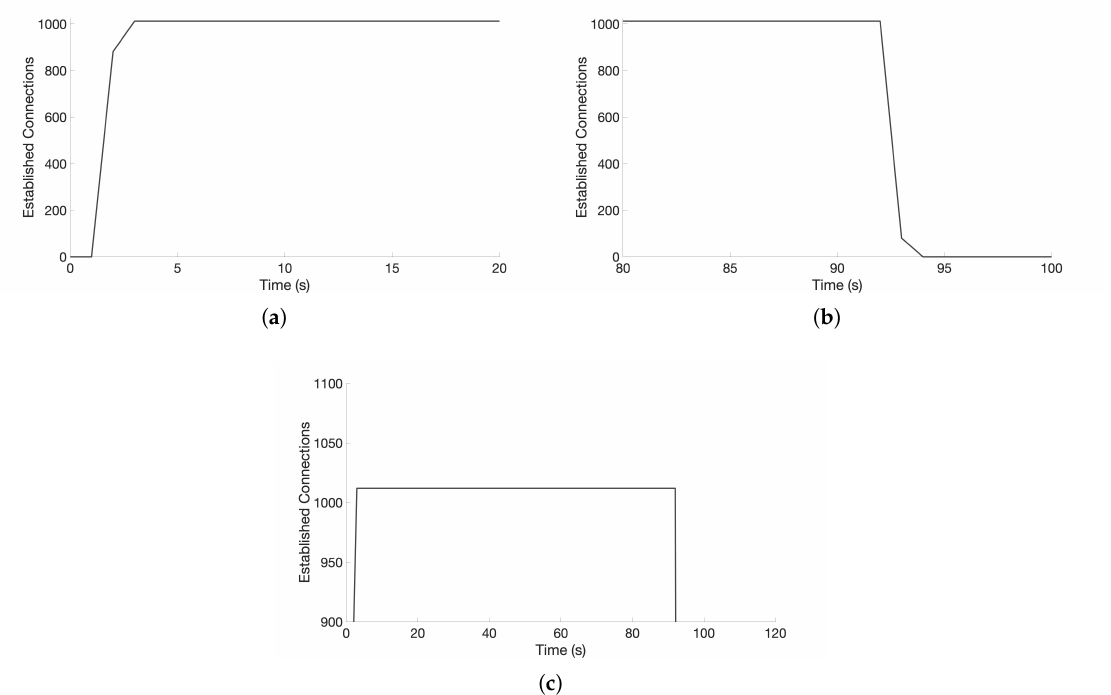
Figure 2. Effects of a SlowITe attack against an Eclipse Mosquitto MQTT service. ( a ) First 20 s of the attack. ( b ) Temporal window reporting connections closures. ( c ) Analysis of the DoS state on the